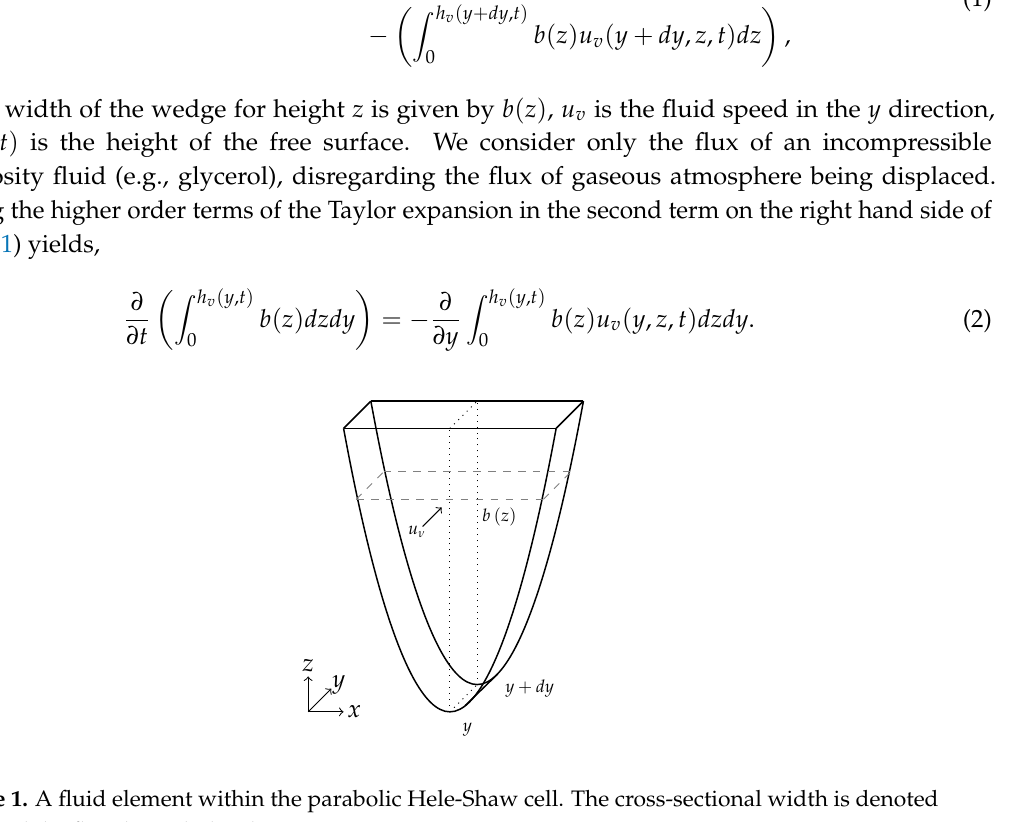
Figure 1. A fluid element within the parabolic Hele-Shaw cell. The cross-sectional width is denoted b ( z ) , and the flux through the element is u ν